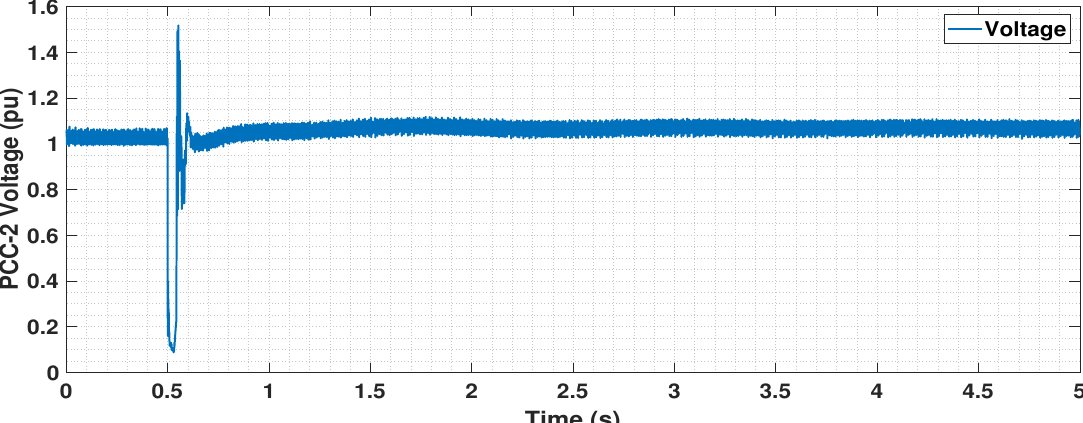
Figure 37. Voltage in p.u. at PCC-2 upon three-phase line to ground fault in the middle of cable-1.